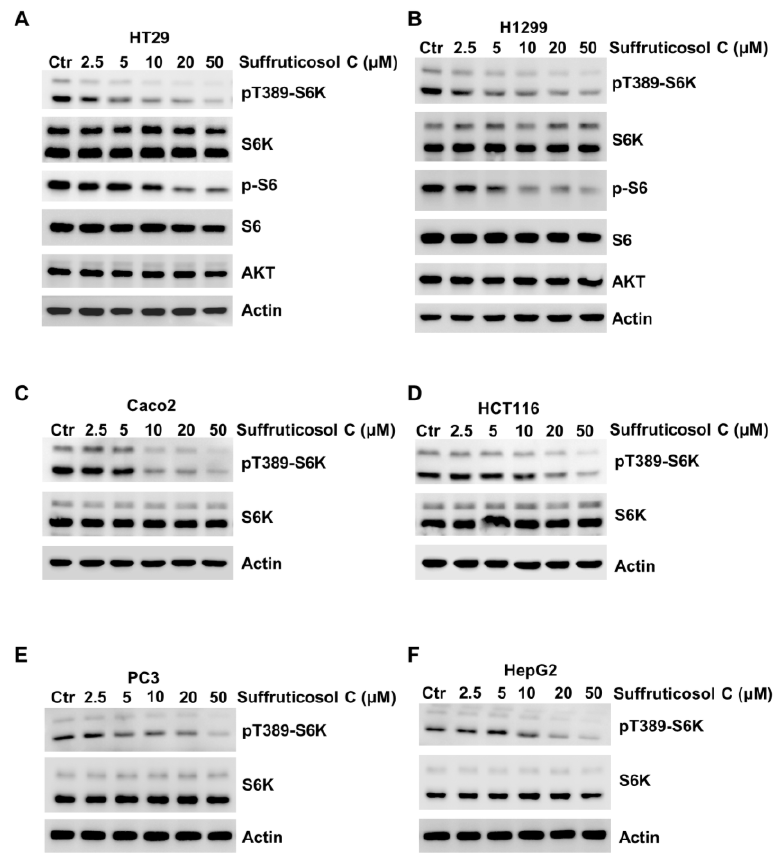
Figure 6. Suffruticosol C inhibits mTORC1 activation. HT29 ( A ), H1299 ( B ), Caco2 ( C ), HCT116 ( D ), PC3 ( E ), and HepG2 ( F ) cells were treated with different concentrations of suffruticosol C for 24 h, and the level of pT389-S6K, p-S6, and the indicated protein were detected by WB.